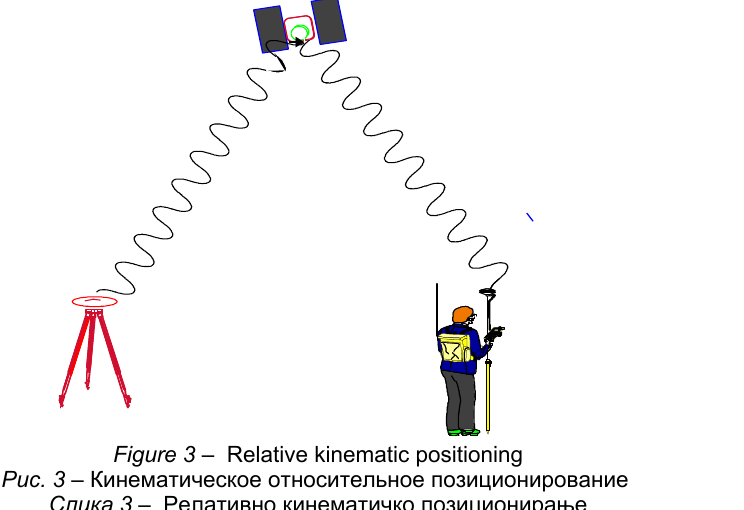
Слика 3 – Релативно кинематичко